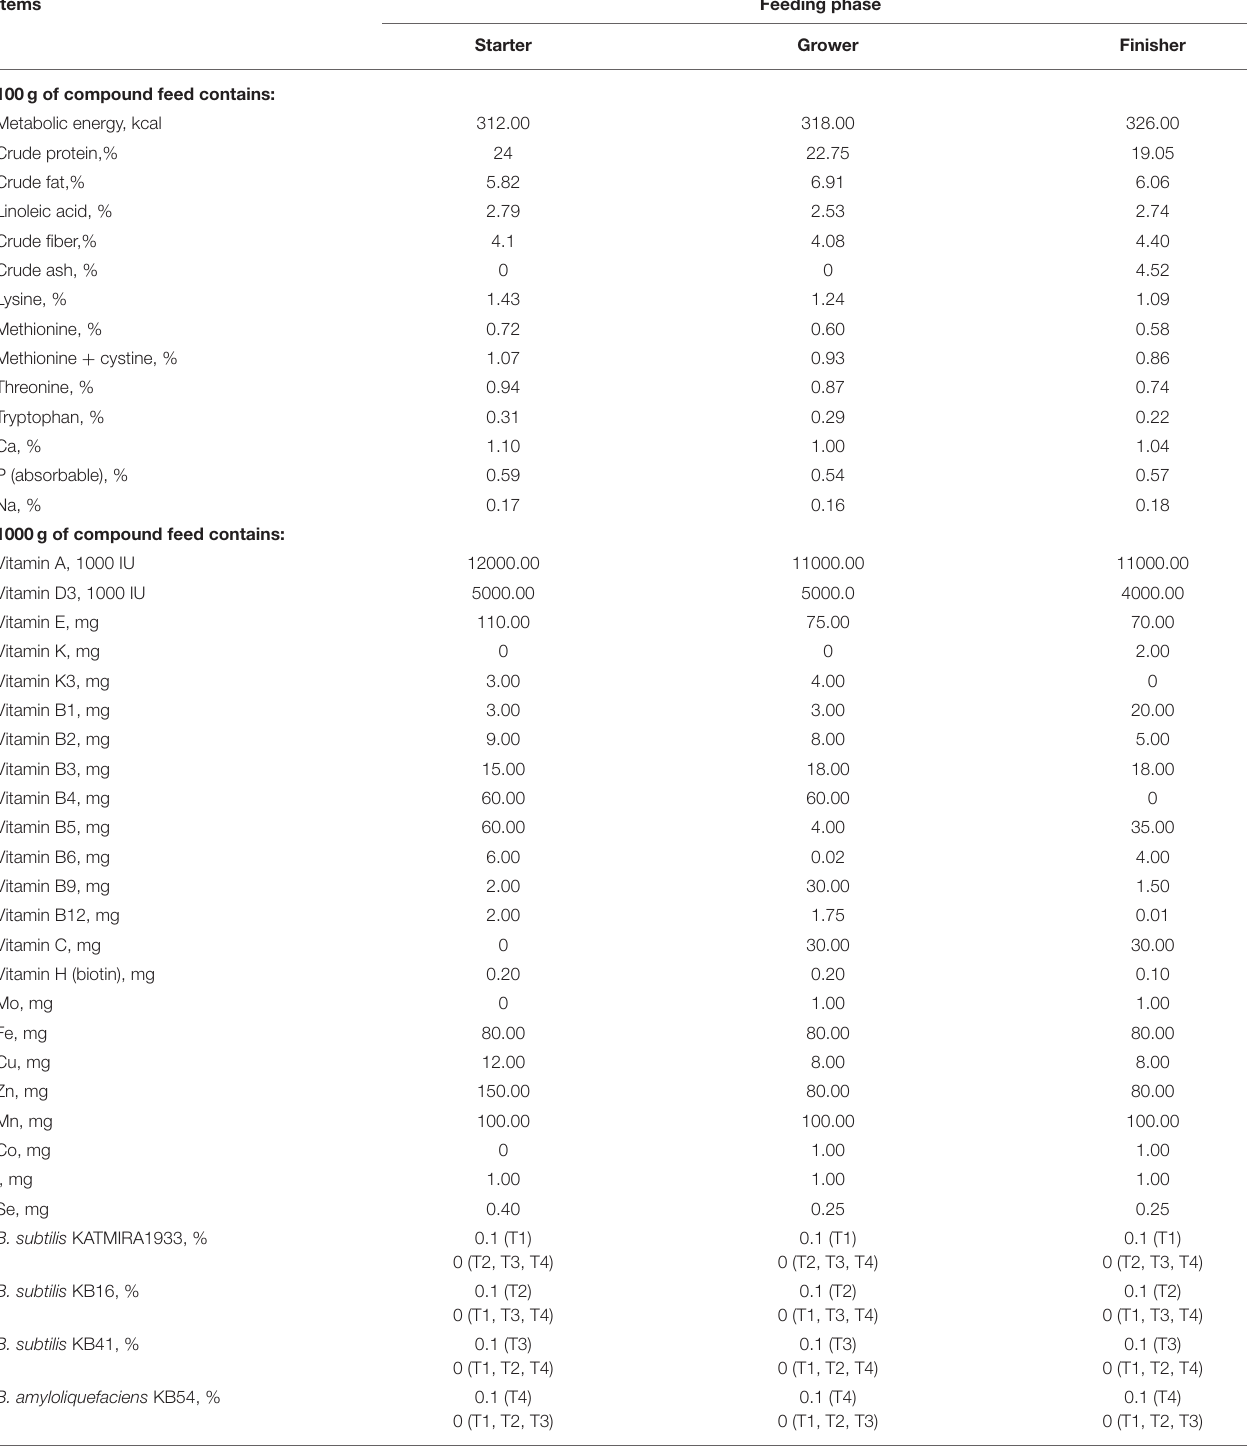
TABLE 1 | Nutrient content of the experimental diets a . Items Feeding phase Starter Grower Finisher